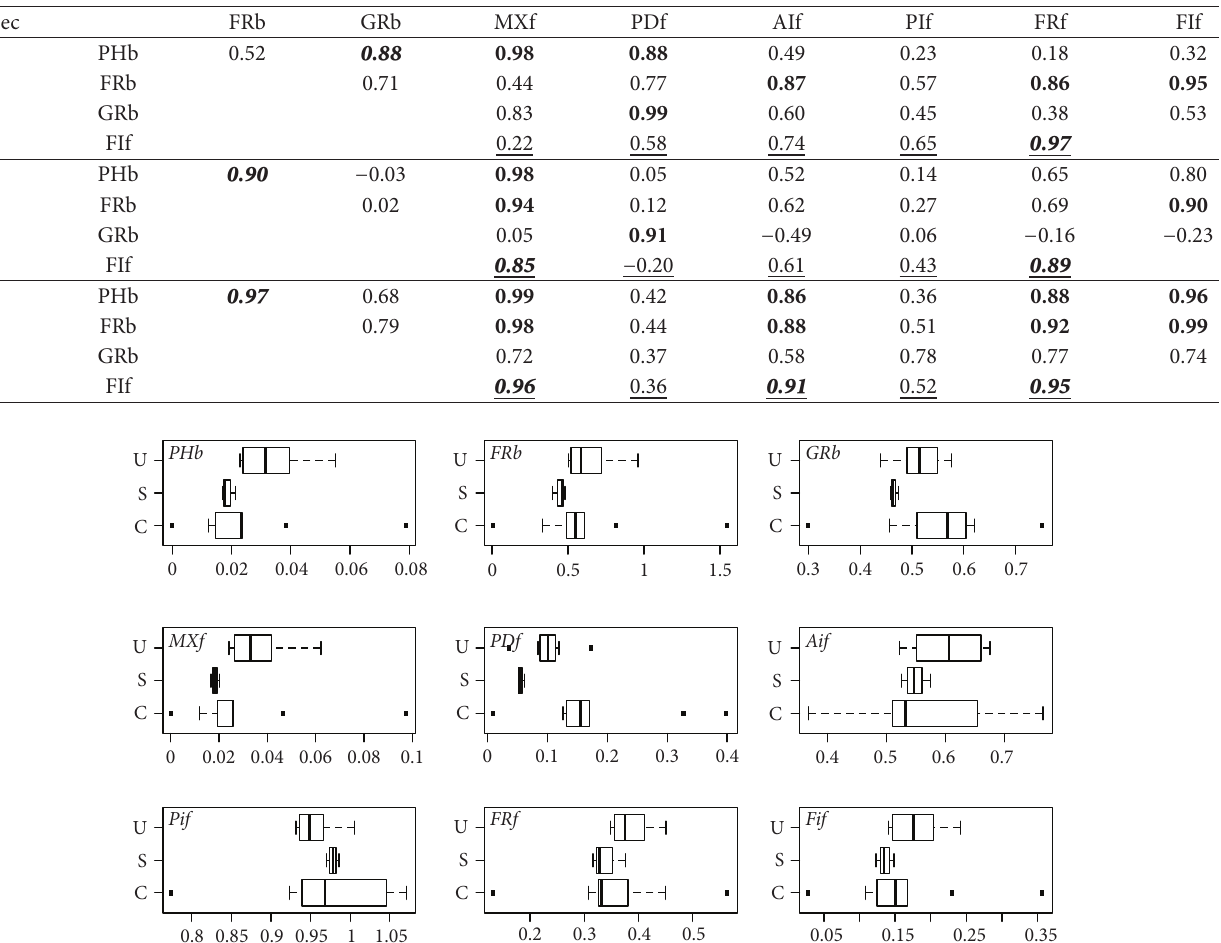
, re�ectance , and transmittance ). High values ( 0.85) are 𝐴𝐴 𝑅𝑅 𝑇𝑇 >